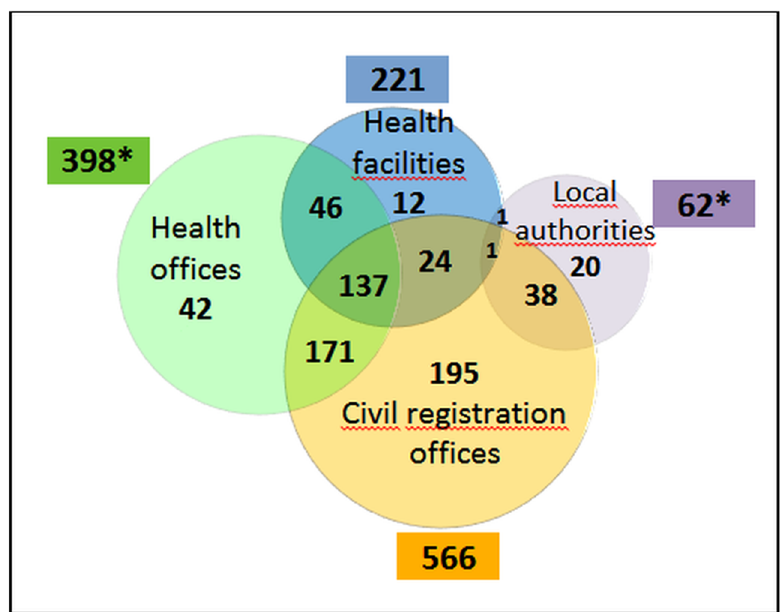
Fig 2. Deaths among WRA after record linkage between data sources (N = 690). (cid:3) including 2 other deaths identified by both health offices and local authorities. https://doi.org/10.1371/journal.pone.0188070.g002 represented 12.2% of all deaths of WRA. External causes (including road accident, suicide, assault, complications of medical care and poisoning) accounted for 14.3%. However, 112 deaths (16.2%) were classified as ill-defined or as unknown cause due to incomplete informa- tion (Fig 3).